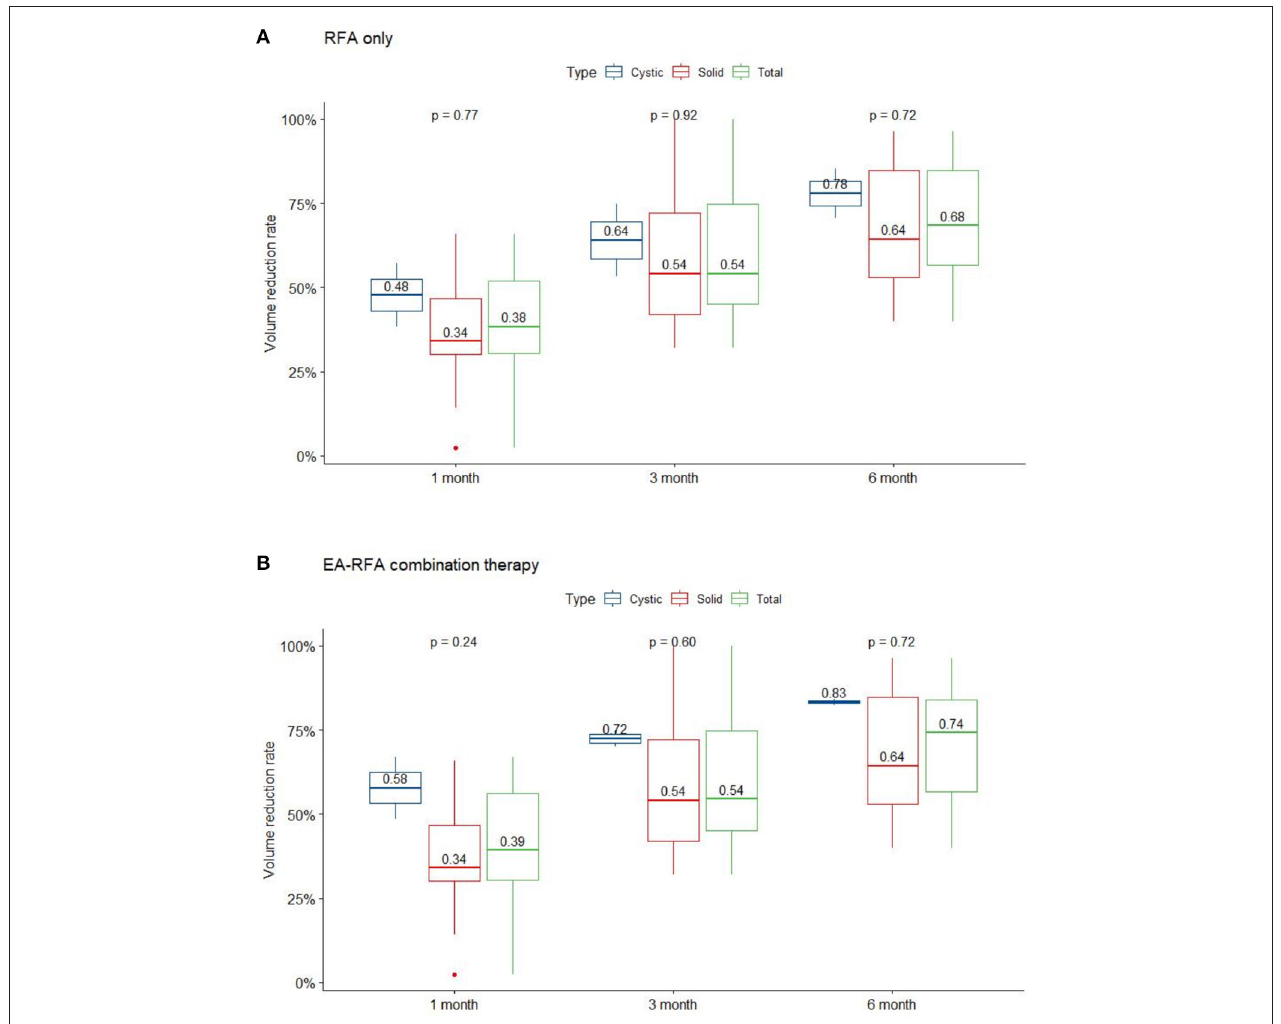
FIGURE 1 | VRR changes of the three nodule composition groups of BTN at each follow-up. Changes in RFA only (A) , and EA-RFA combined therapy (B) of the different echogenicity groups of BTN at each follow-up. BTN, benign thyroid nodule; VRR, volume reduction